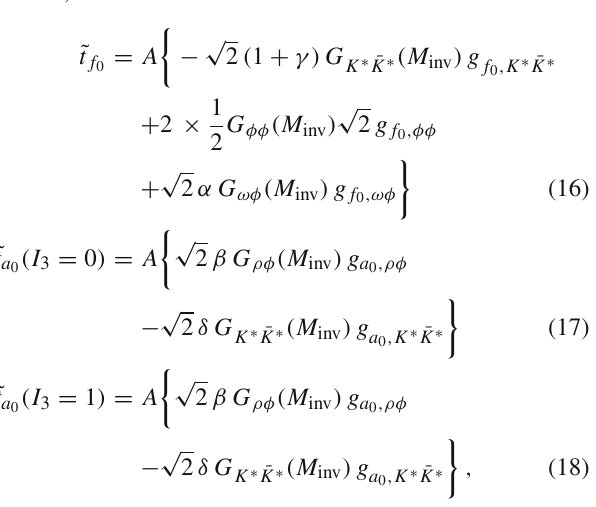
Fig. 4 K ∗ ¯ K ∗ → K ¯ K transitions driven by π exchange ( a ) and φ(ρ,ω,φ) → K ¯ K transitions driven by K exchange ( b )